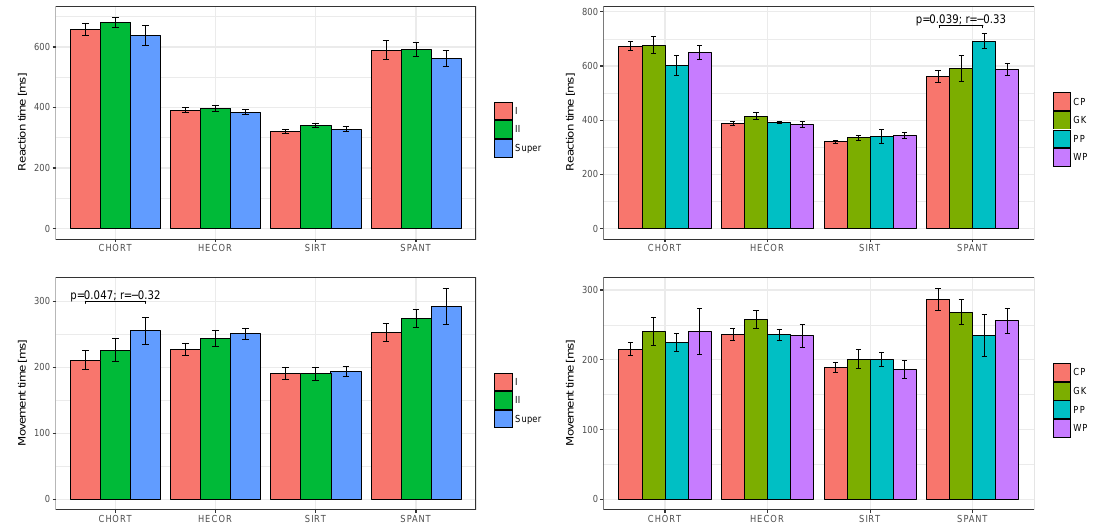
Figure 2. League of games; I—1st league, II—2nd league, Super—Superliga; Player’s position on the court; CP—centre player, GK—goalkeeper, PP—pivot player, WP—wing